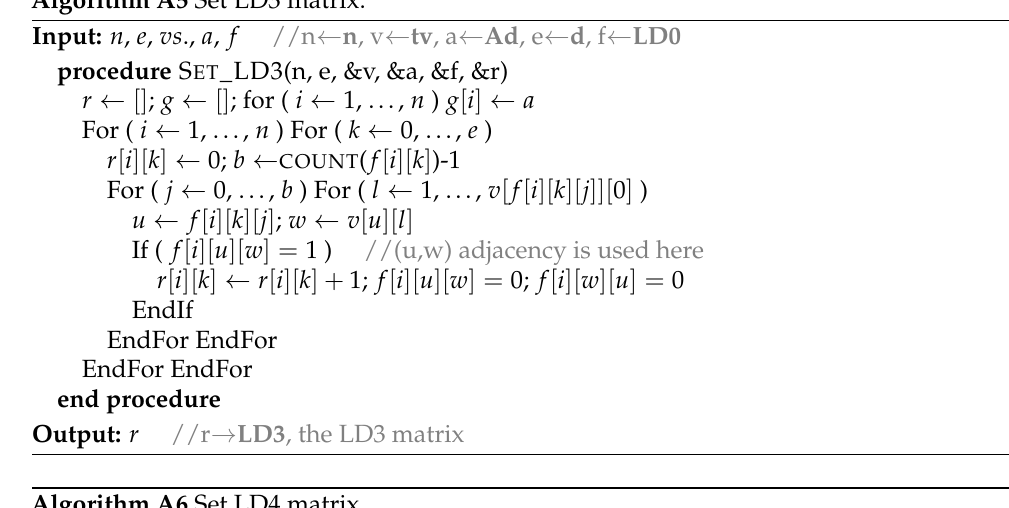
Algorithm A6 Set LD4 matrix.